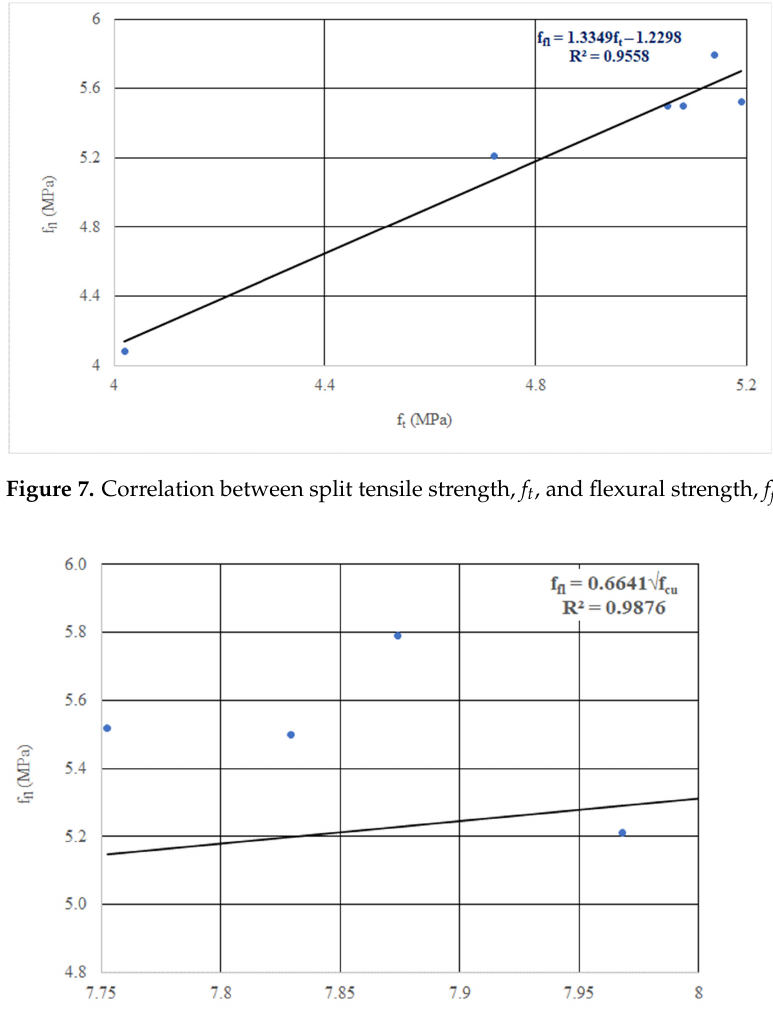
Figure 8. Correlation between compressive strength, f cu , and flexural strength, f fl .